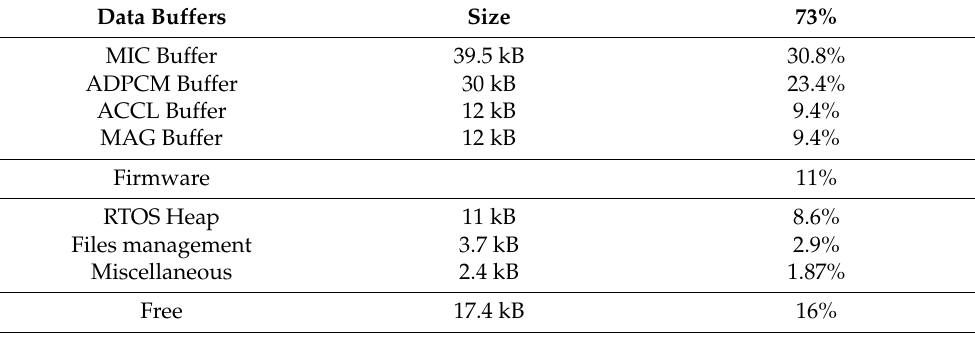
Table 3. RAM Table 3. RAM usage.